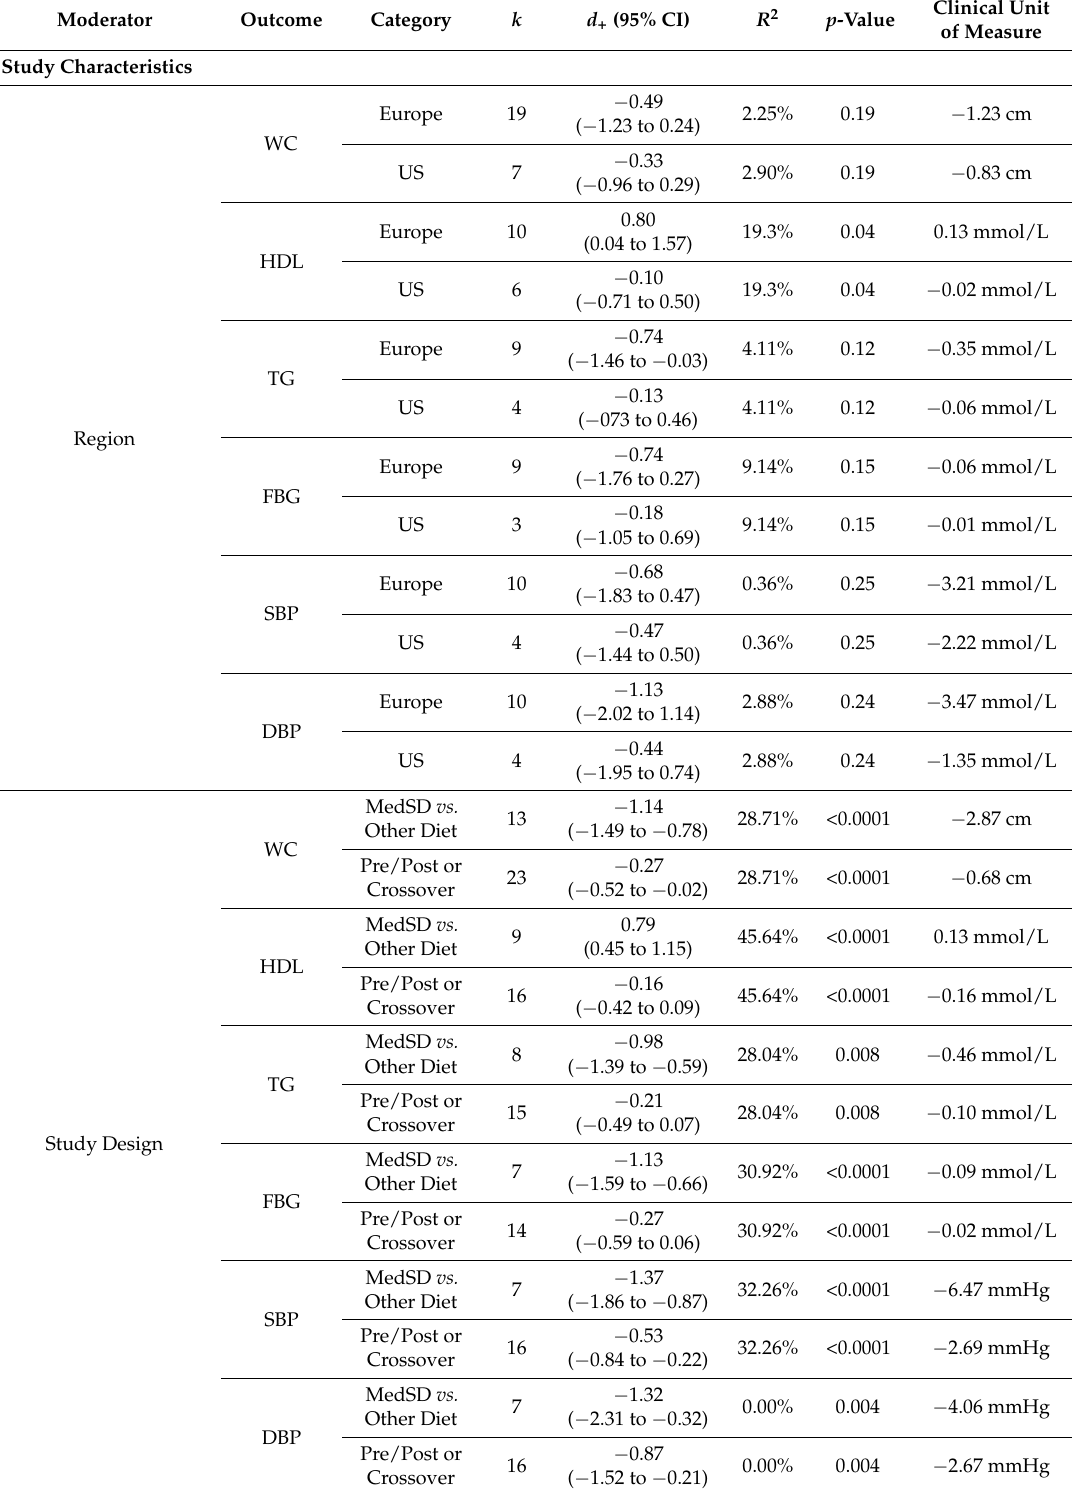
Table 3. Significant Moderator Analysis